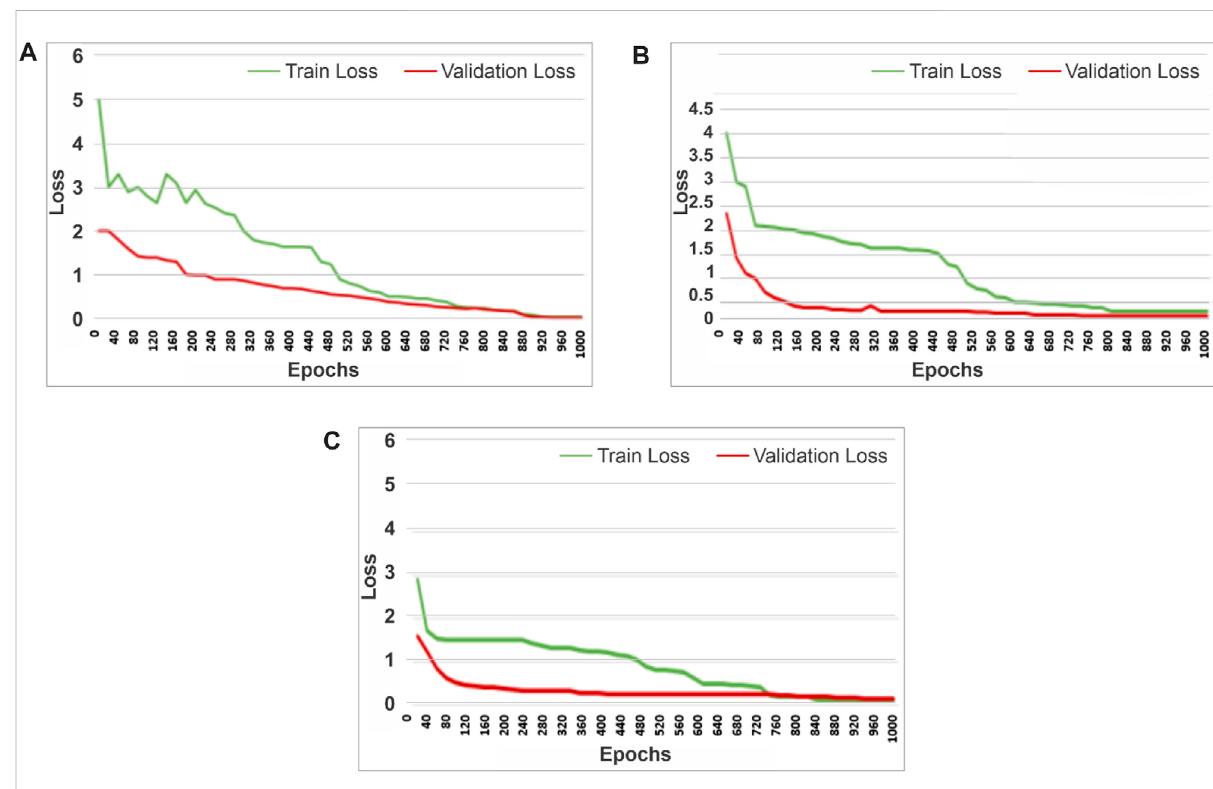
FIGURE 8 ThreelossfunctionsfortheMTL-CNN.Thelossfunctionin (A) referstothetraininglossofandvalidationlossfortask1,whereas (B) referstothe loss function of task 2, and (C) denotes the loss for the shared